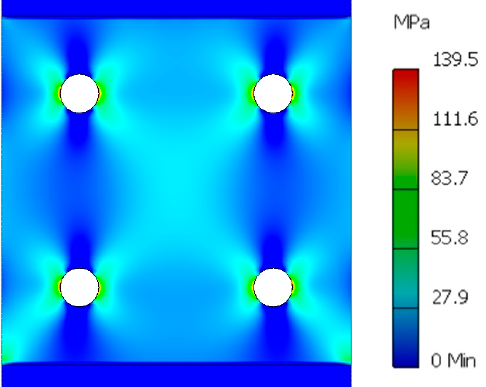
Figure 6. FEM calculation of force induced stresses in the tensed amorphous ribbon for 10 N load.